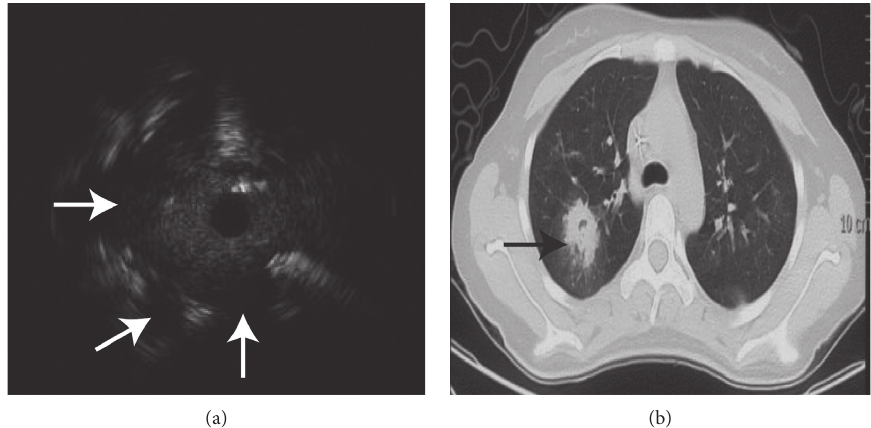
Figure 2: EBUS demonstrated heterogeneous internal echoes, anechoic areas, and luminant areas (a). There were three anechoic areas ((a) white arrows) in the image from a 21-year-old female with a peripheral lesion over the right upper lobe with `Aspergillus infection identified by mNGS ((b) black